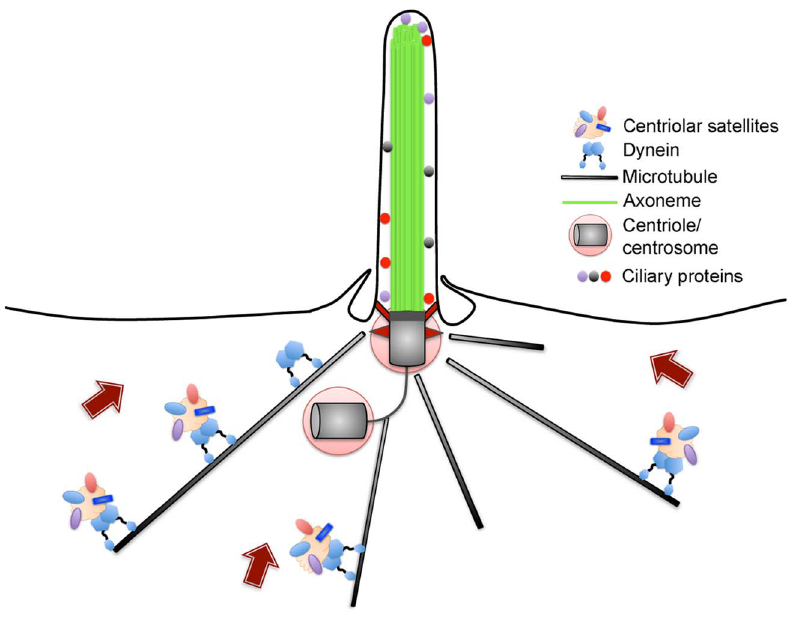
Figure 1. Schematic of centriolar satellites undergoing microtubule-dependent movement towards the centrosome and cilium. Satellites are composed of a number of proteins, including Azi1, which are typically found in a region surrounding the centrosome. Satellites mediate the trafficking of some proteins destined for the cilium but can also inhibit the movement of other proteins to the centrosome-cilium complex.